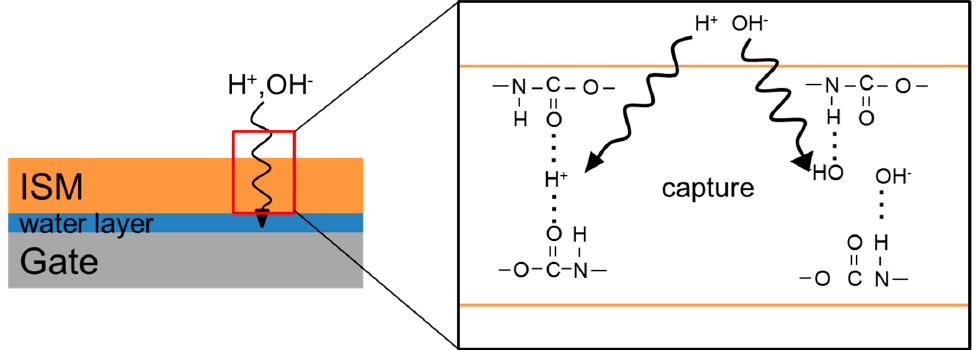
Figure 5. The hypothesis of urethane bond capture of H + and OH - by hydrogen bonds (in whole saliva).